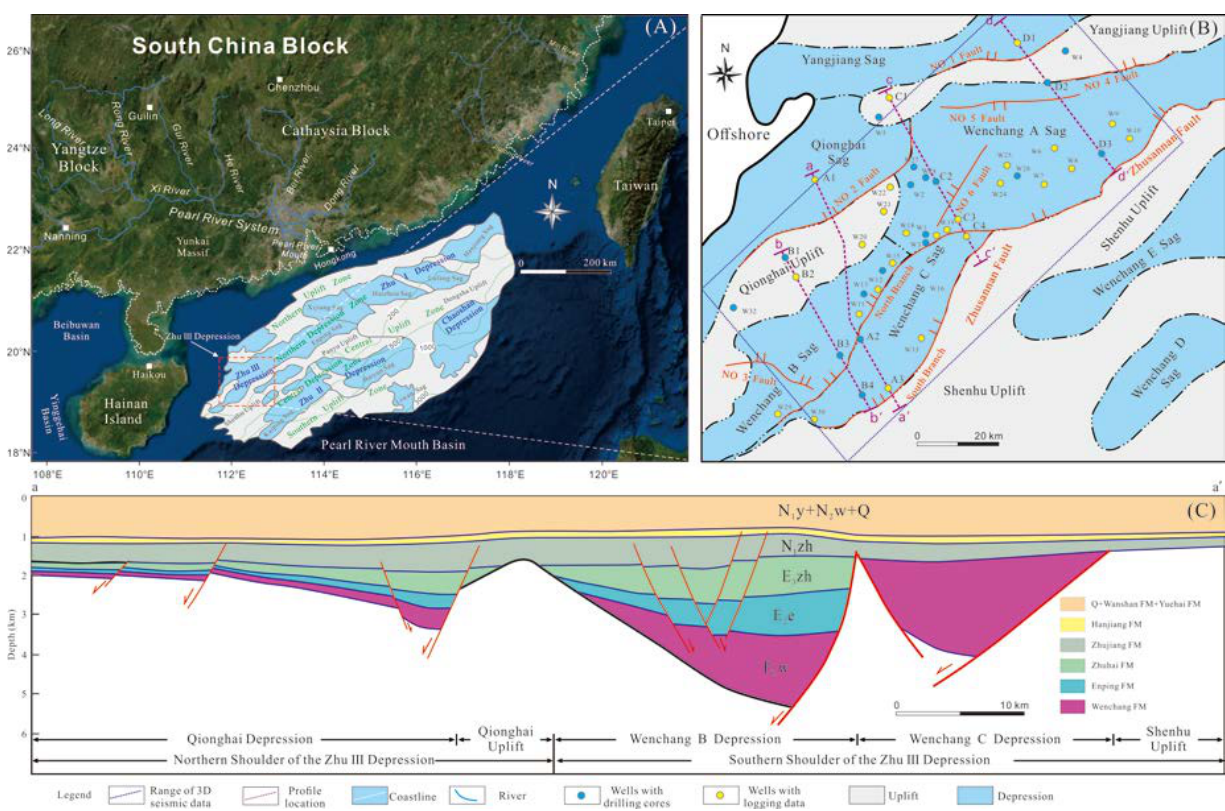
Figure 1. ( A ) Geological map of South China showing the regional setting and tectonic elements of the PRMB with major modern river systems that discharge into the northern South China Sea (modified after Liu et al. [50]). ( B ) Map showing tectonic elements of the Zhu III Depression and geographic locations of borehole samples. ( C ) Interpreted NE-trending profile in the Zhu III Depression and the location of the profile is shown in ( B ).